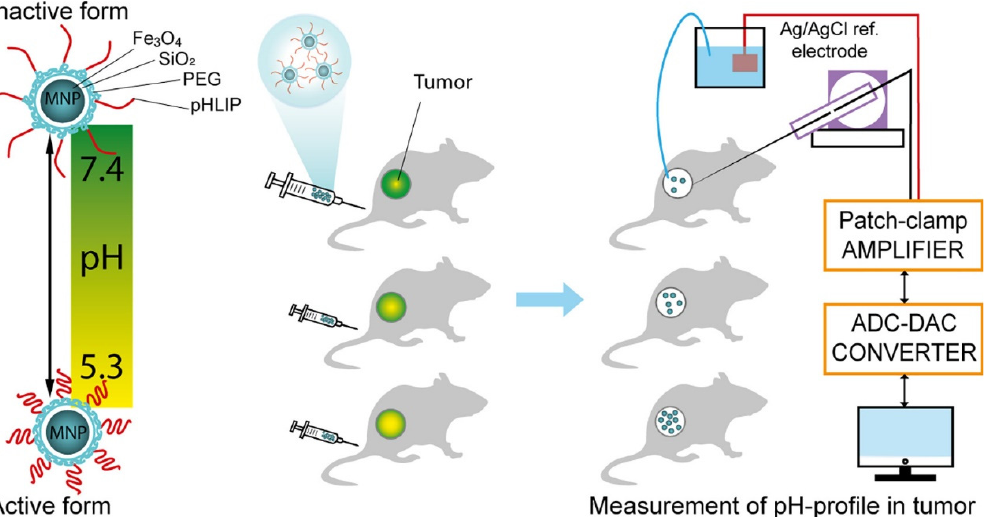
Figure 3. The imaging route of pH-triggered delivery of magnetic nanoparticles conjugated with pH (low) insertion peptide. Reprinted from [47]. Copyright 2022 Elsevier.